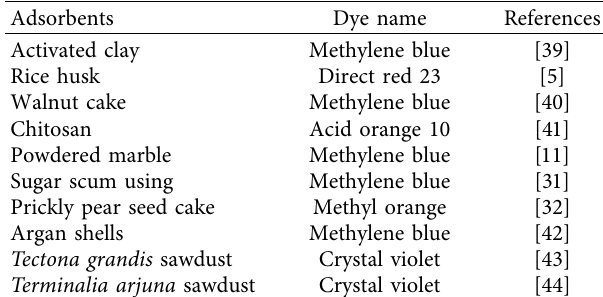
Table 3: List of low-cost adsorbents used for dyes